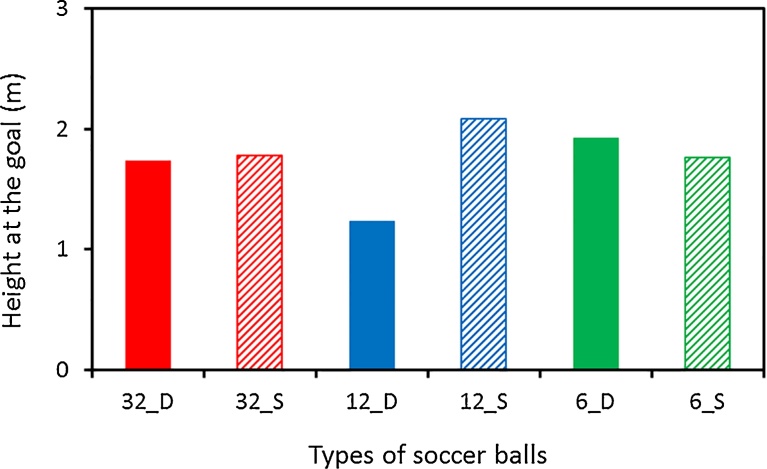
Locations where the six balls would cross the goal plane (v0 = 30 m s−1 and θ0 = 18°).